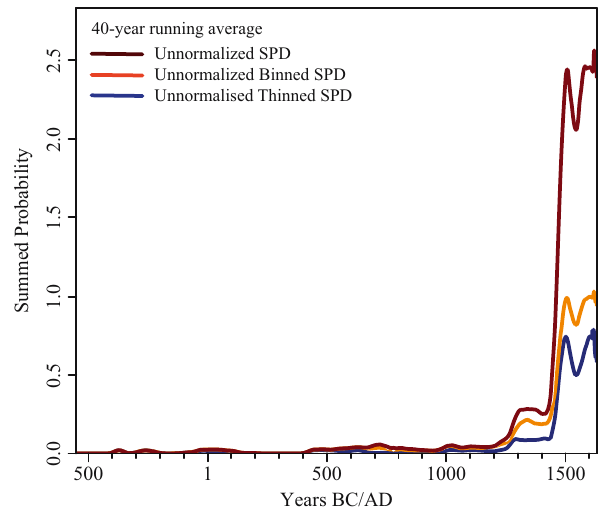
Figure 2: Summed probability density plots using 40 year running means and unnormalized date calibrations and SPDs. The binned SPD has 216 bins and the thinned SPD is calculated with one randomly selected date from each of the 122 sites represented in the